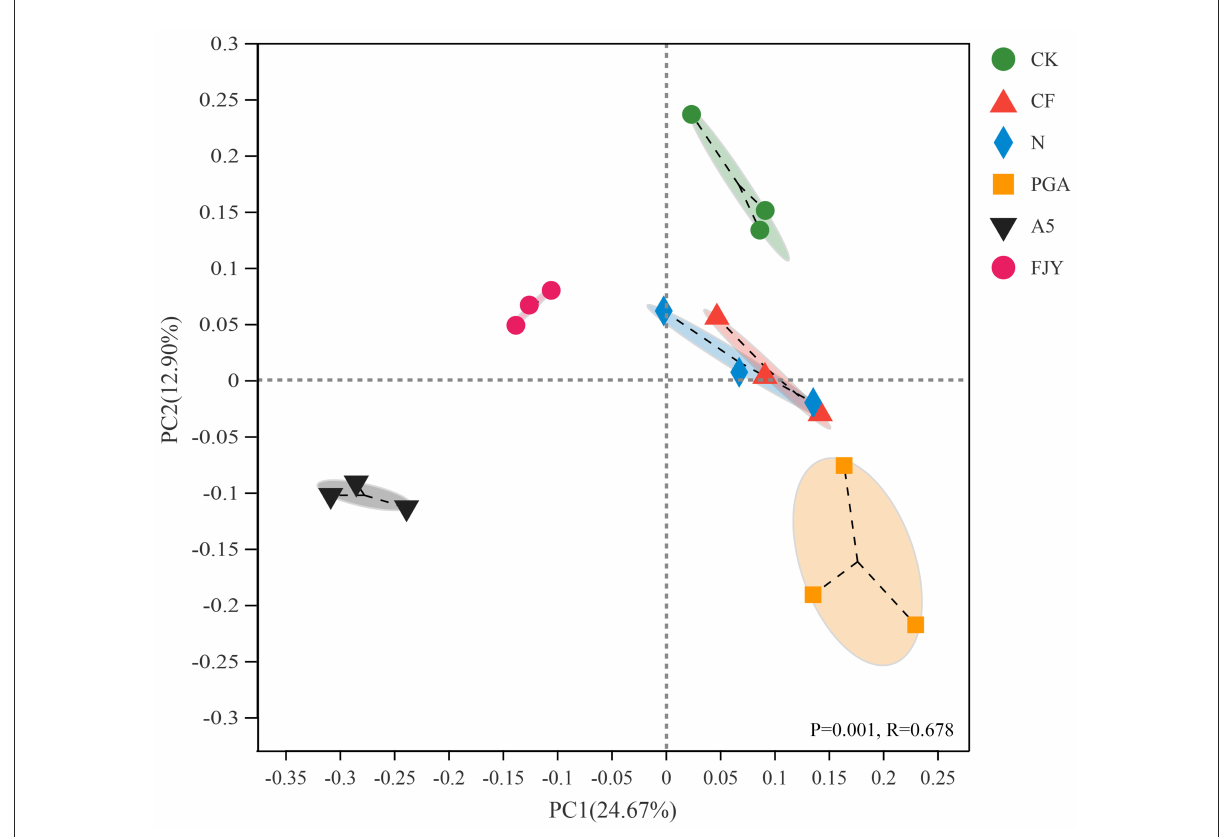
FIGURE3 PCoA of bacterial community structure in the rhizosphere soil based on the Bray–Curtis matrix.